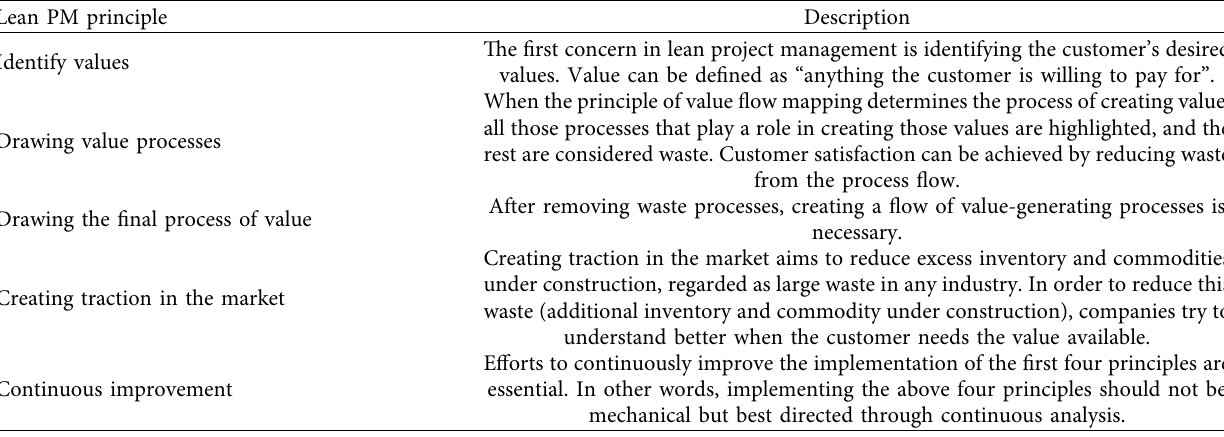
Table 2: Lean project management principle (made by